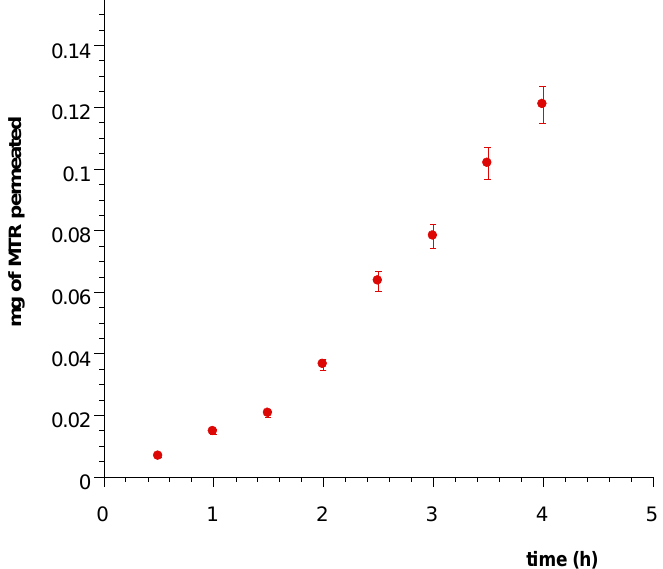
Figure 7. Plot of the cumulative amount of MTR permeated across porcine buccal mucosa vs. time from Tablet A soaked with simulated saliva. Values are presented as means ± SE ( n = 12).